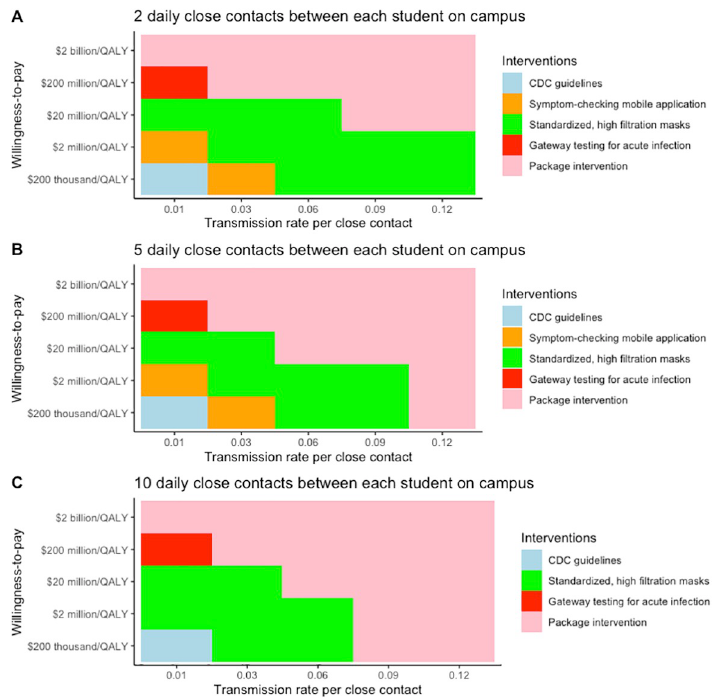
Fig 3. Multi-way sensitivity analysis identifying the most cost-effective intervention at different values of the number of close contacts between students on campus, the transmission rate per close student contact, and willingness-to-pay at a 2% prevalence of actively infectious cases in the